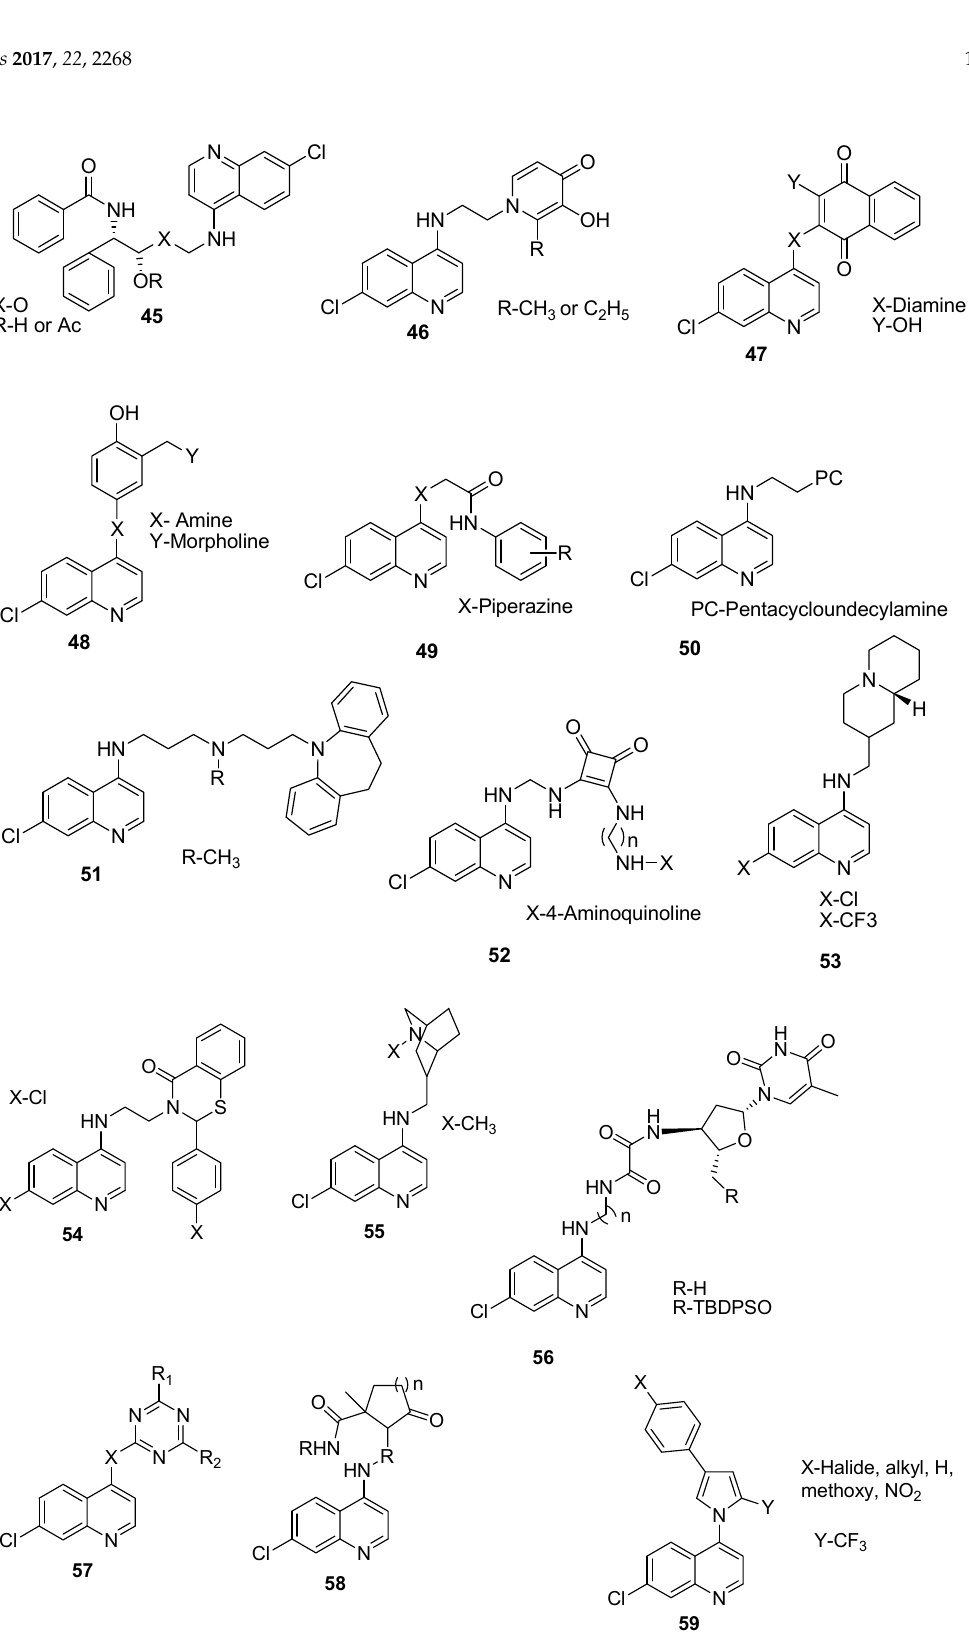
Figure 9. Hybrid compounds containing quinoline and other ring systems. Hybrid compounds with a dibenzylamino moiety were effective against chloroquine-resistant and -sensitive strains of P. falciparum when compared to those with diphenylamino group. The effect of the length of the linker on the antimalarial activity of the hybrids was not significant [82]. Ribeiro et